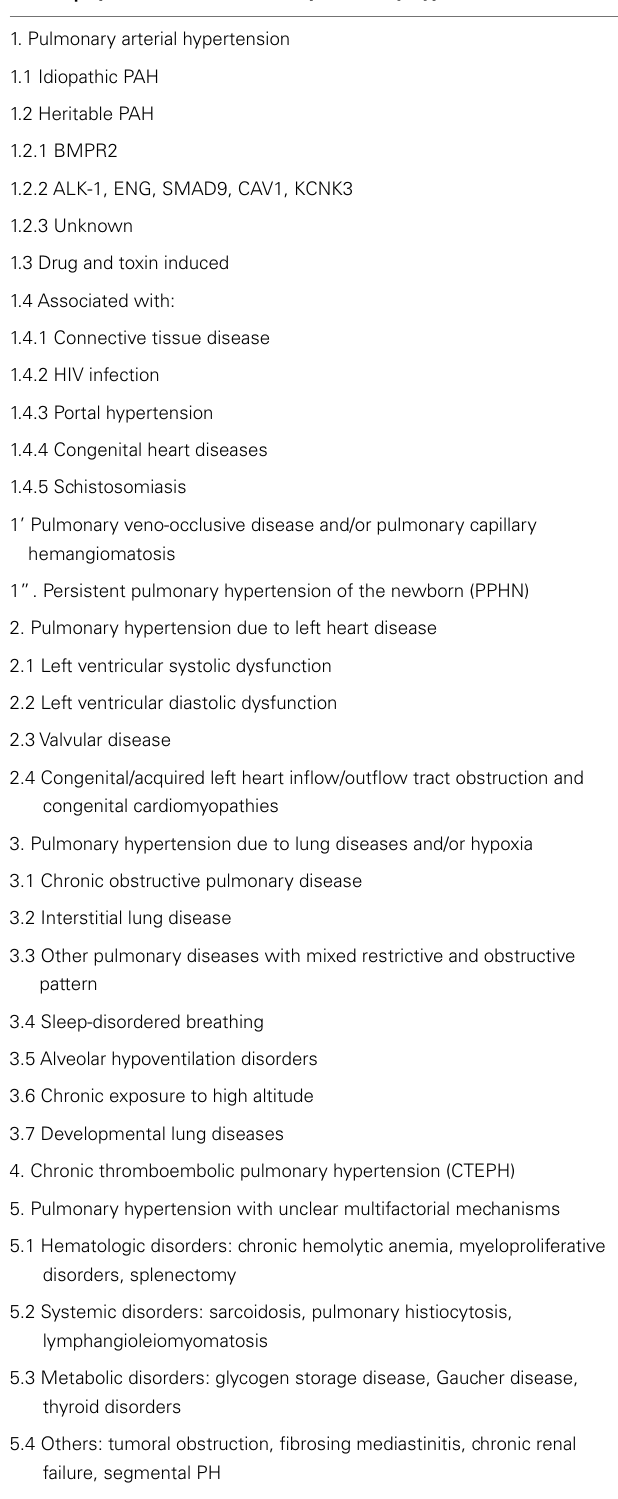
Table 1 | Updated classification of pulmonary hypertension